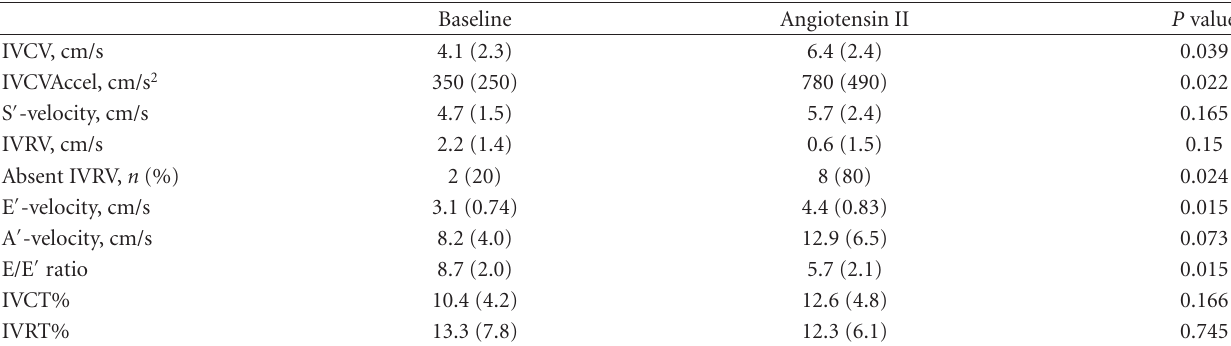
Table 4: Fetal left ventricular tissue Doppler-derived parameters at baseline and during angiotensin II infusion. Data are presented as mean (SD) or n